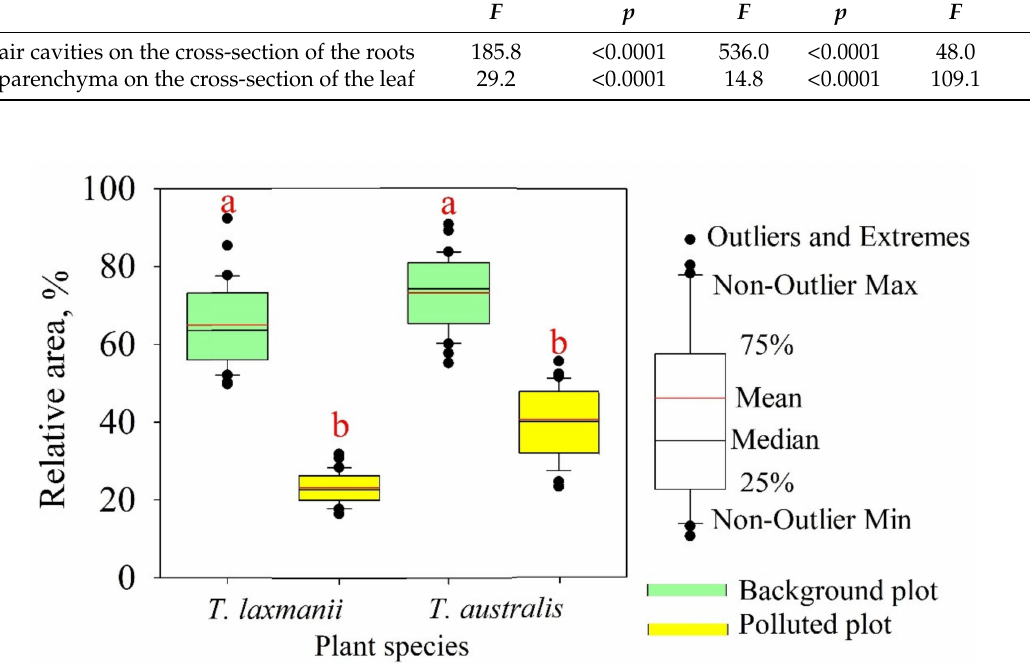
Figure 5. Relative area of air cavities on the cross-section of soil roots of T. australis and T. laxmannii growing in the back- ground and polluted plots. Different letters indicate significant differences ( p < 0.05) resulting from the post hoc Tukey’s HSD